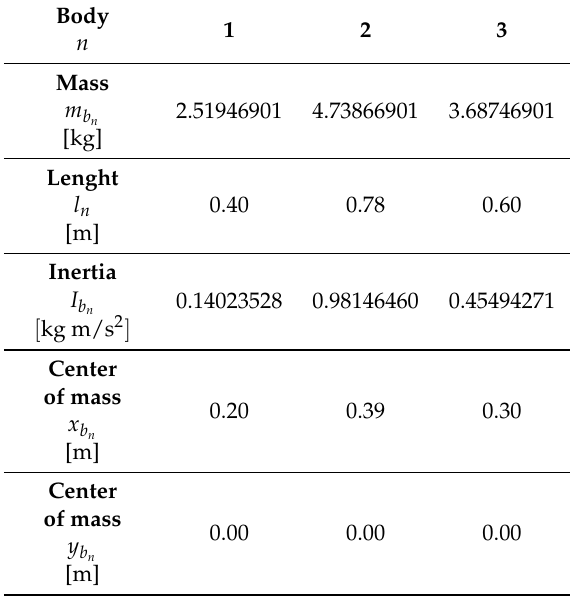
Table 1. Parameters of the four-bar mechanism used in the